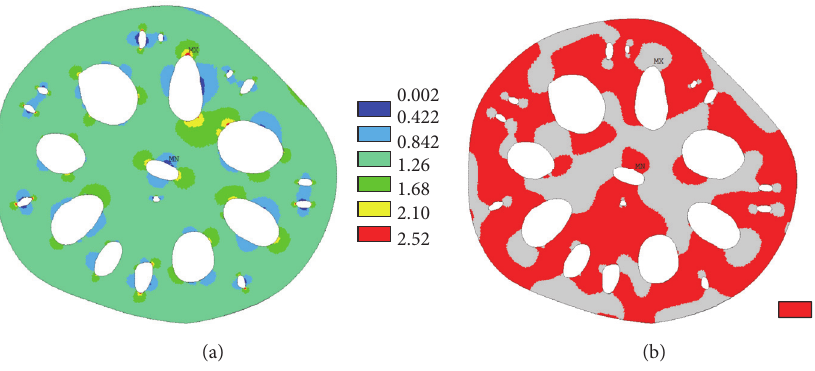
Figure 10: (a) HPF in the cross-sectional area of the lotus root and (b) HPF values less than 1.08.